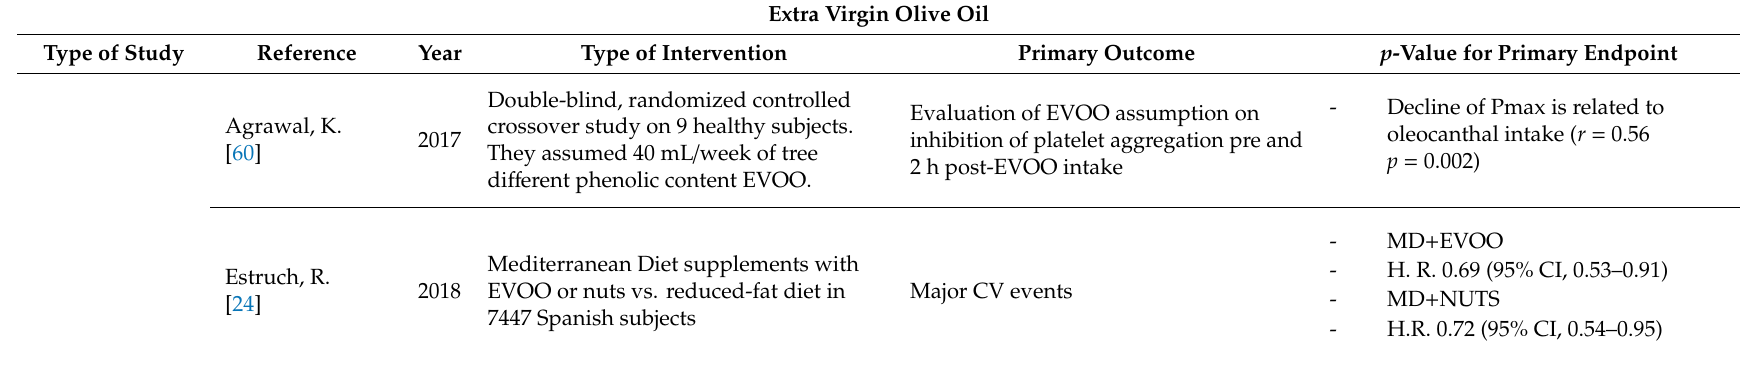
Table 2. Cont. Extra Virgin Olive